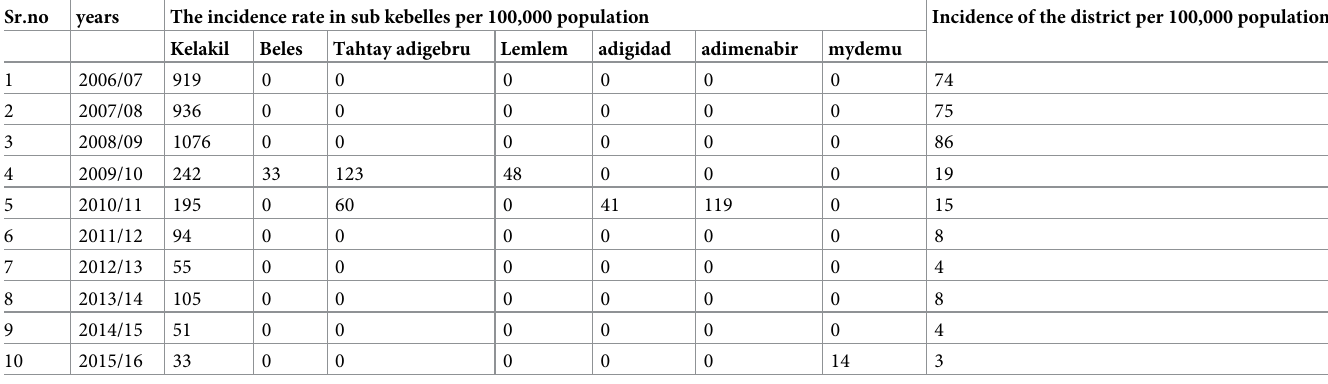
NB. The first year started in September and ends in August of the consecutive